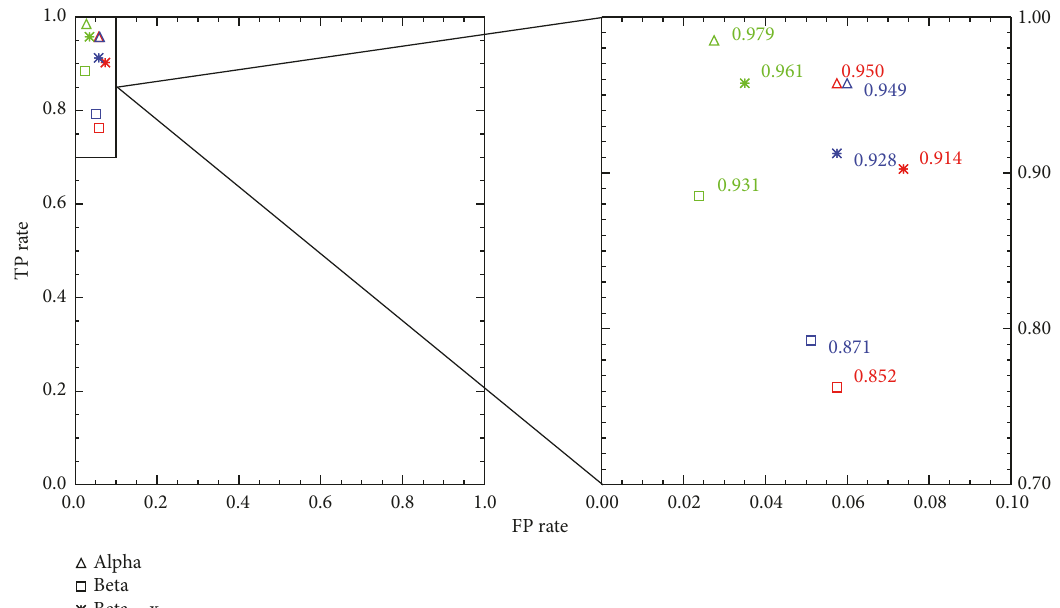
Figure 3: TP rate and FP rate of Alpha, Beta, and Beta-x in model A (red), model B (green), and model C (blue). The AUC value is marked beside each point.